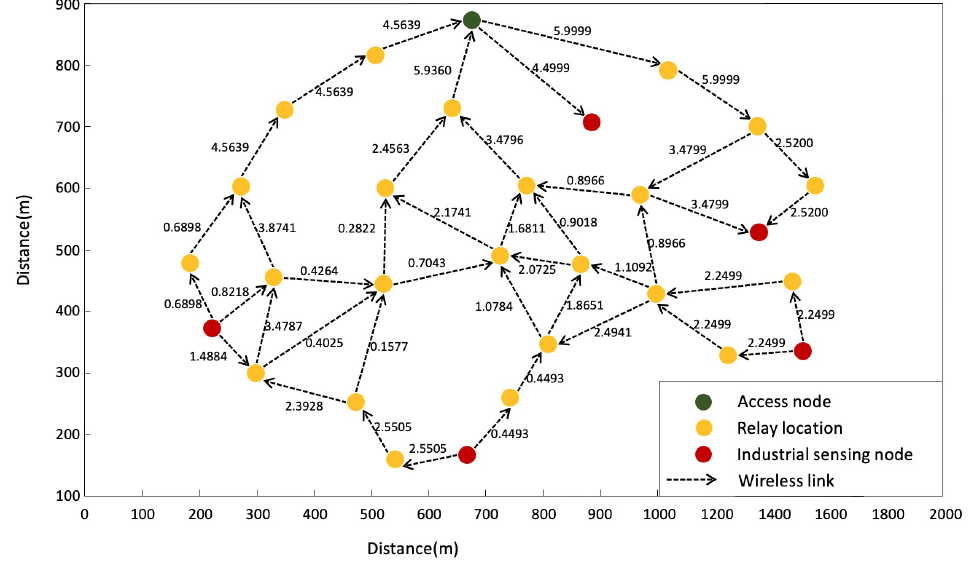
Figure 3. Optimal routing and flow control for intra-domain